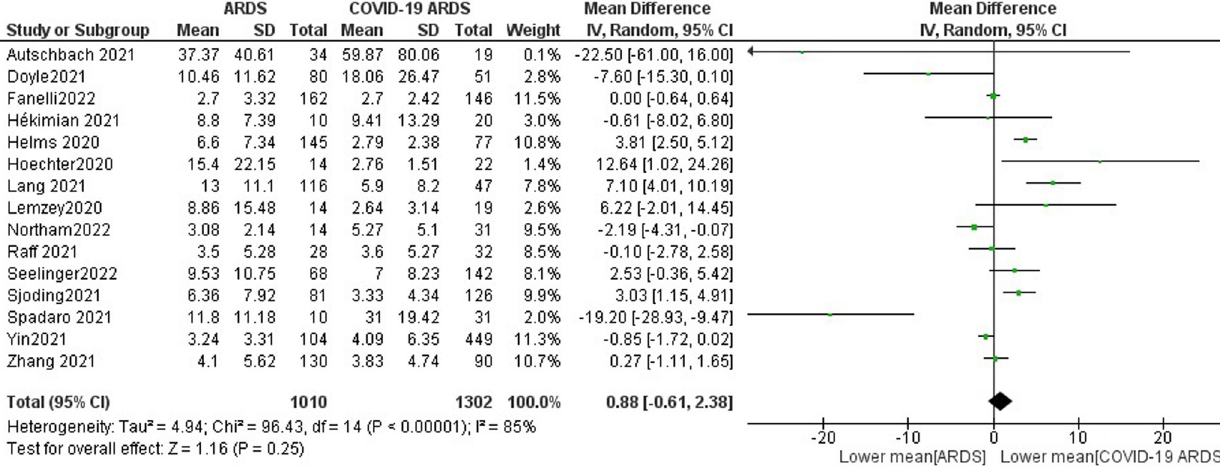
PLOS ONE | https://doi.org/10.1371/journal.pone.0277000 February 6,